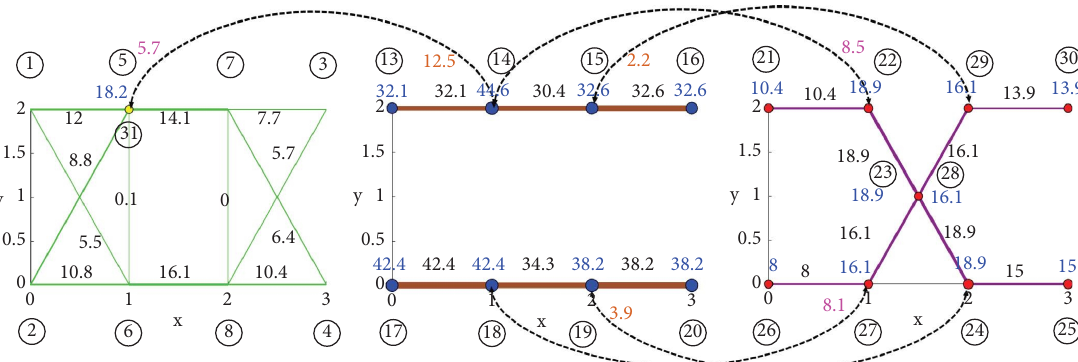
Figure 10: Flow distribution of HGSADC